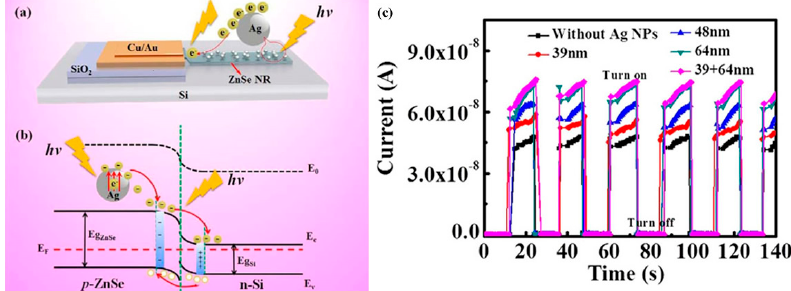
Figure 13. ( a ) Schematic illustration of the localized surface plasmon resonance excited electrons transfer from Ag nano particles to ZnSe nanoribbon. ( b ) Energy band diagram of ZnSe nanoribbon/Si heterojunction modified with Ag nanoparticles under light illumination. ( c ) Time response spectra of the devices without and with decoration of 39, 48, 64, and 39 + 64 nm Ag nanoparticles measured at zero voltage bias. Reproduced with permission from [45], Copyright 2016, IOP Publishing Ltd.